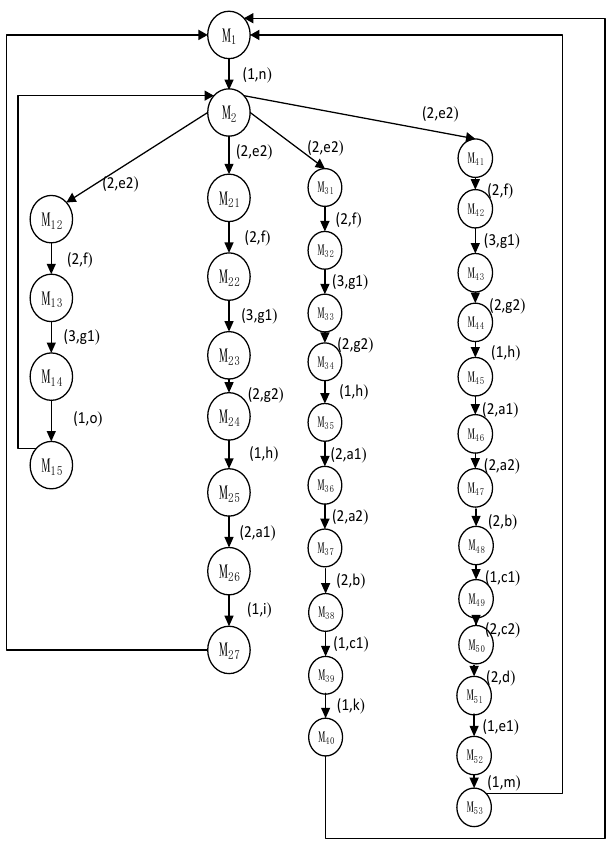
Figure 6. State space of Car2.